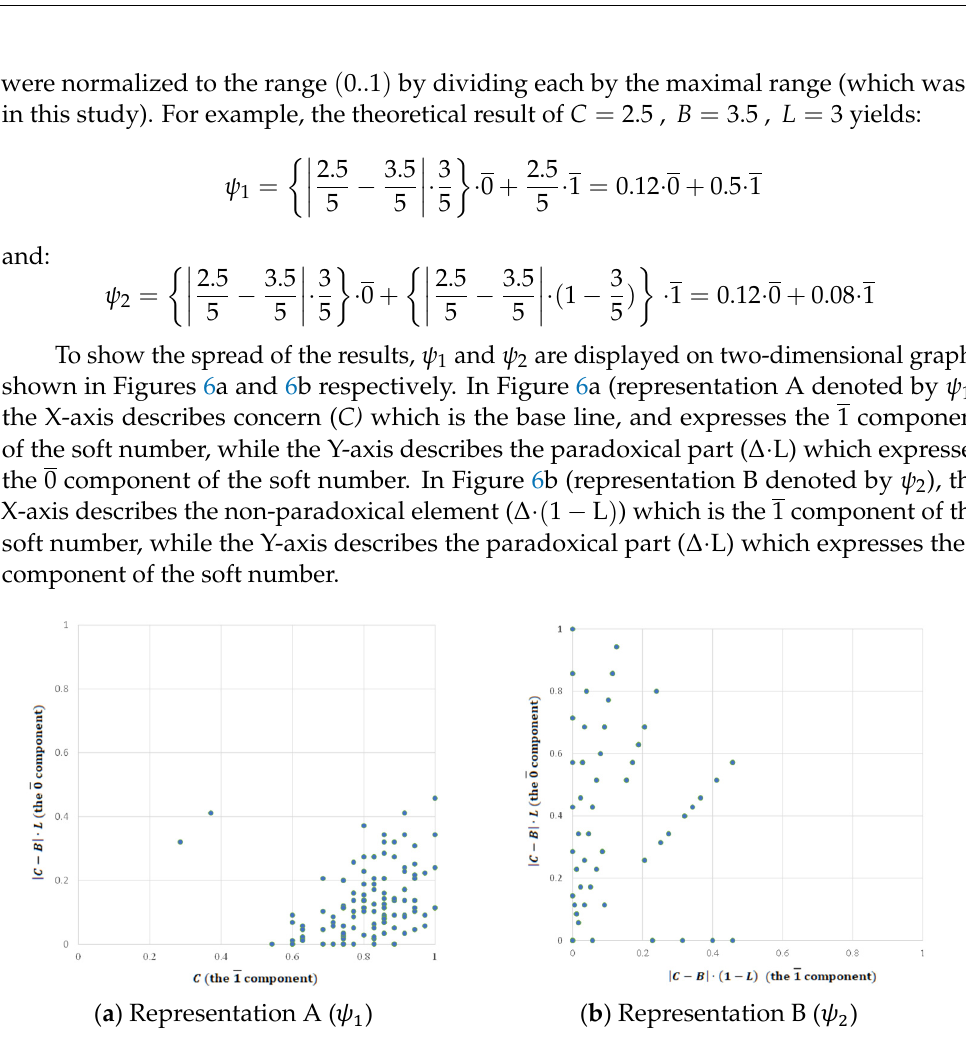
Figure 5. The spread of the results in the privacy paradox space.